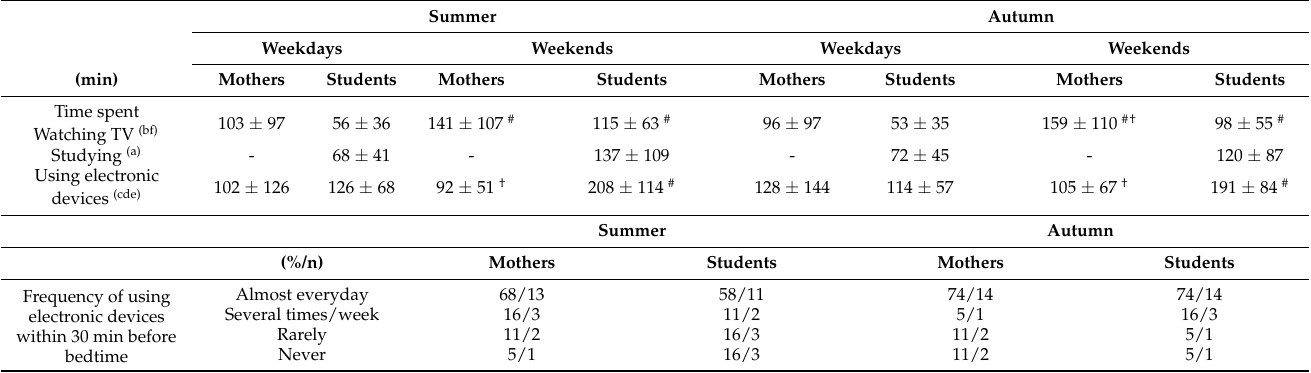
Table 5. The results of domestic behavioral characteristics.